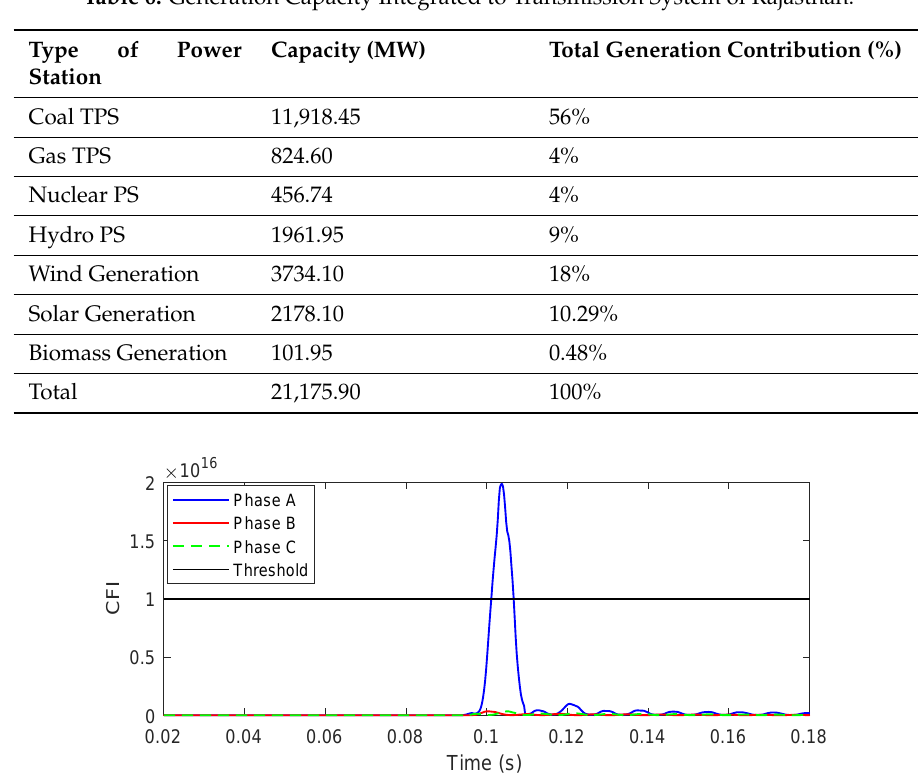
Table 6. Generation Capacity Integrated to Transmission System of Rajasthan.